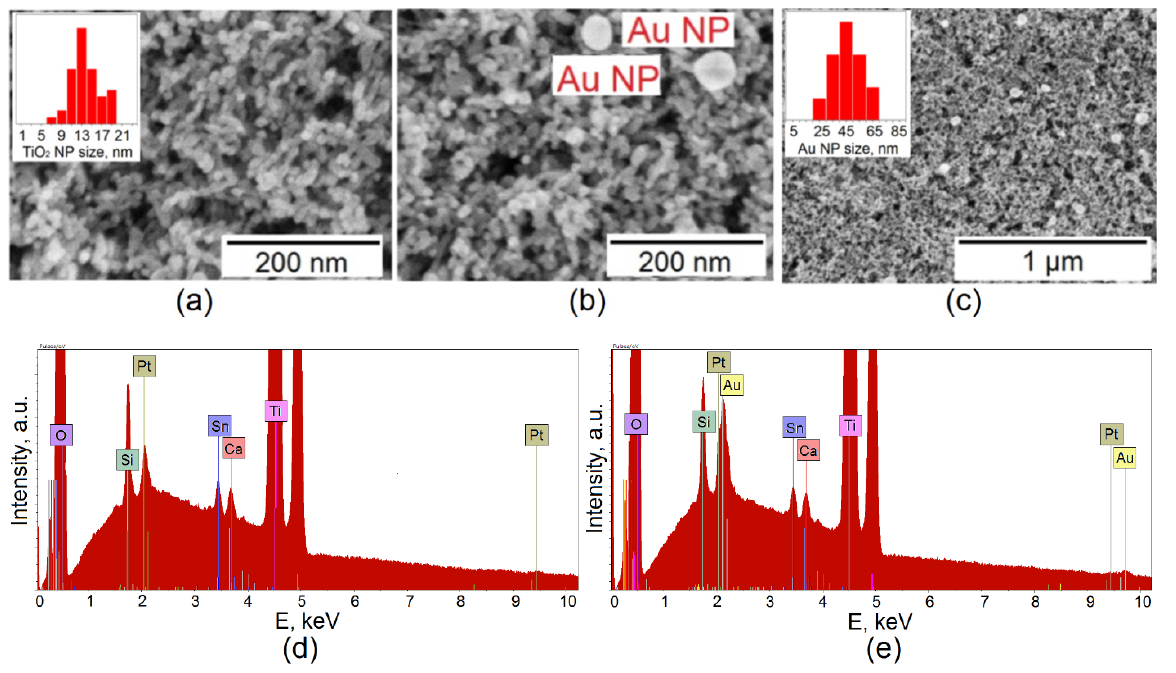
Figure 1. SEM image of the surface of a Au/TiO 2 /FTO composite film at various magnifications ( a – c ); EDS analysis of the photoelectrode before ( d ) and after ( e ) deposition of gold nanoparticles using the LCLD method.